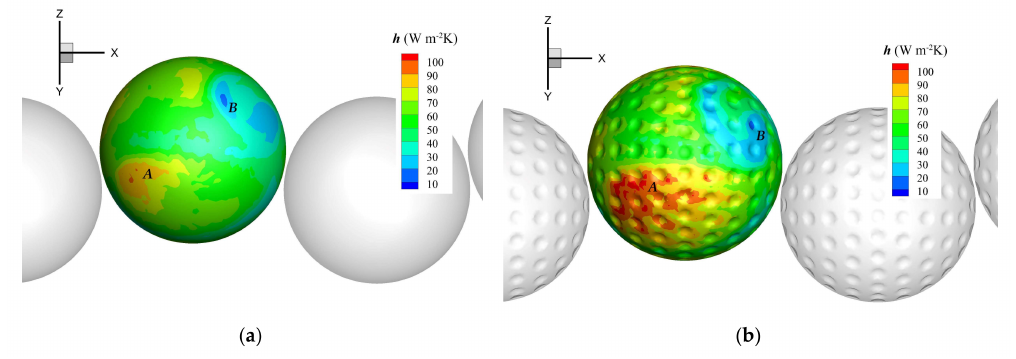
Figure 17. The surface heat transfer coefficient on a smooth or dimpled sphere in packed bed at N = 1.15 ( Re H = 4599) for ( a ) smooth spheres packed bed and ( b ) dimpled spheres packed bed.